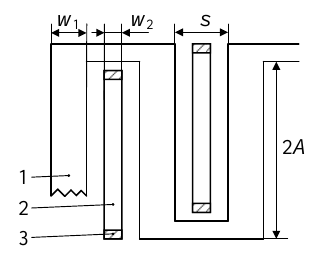
Fig. 3. The fragment of the topology of meander slow-wave system with additional shields grounded at both edges, where 2 A = 20 mm; w 1 = 0.5 mm; w 2 = 0.25 mm; s = 0.65 mm; ɛ r = 7.3; h = 0.5 mm.